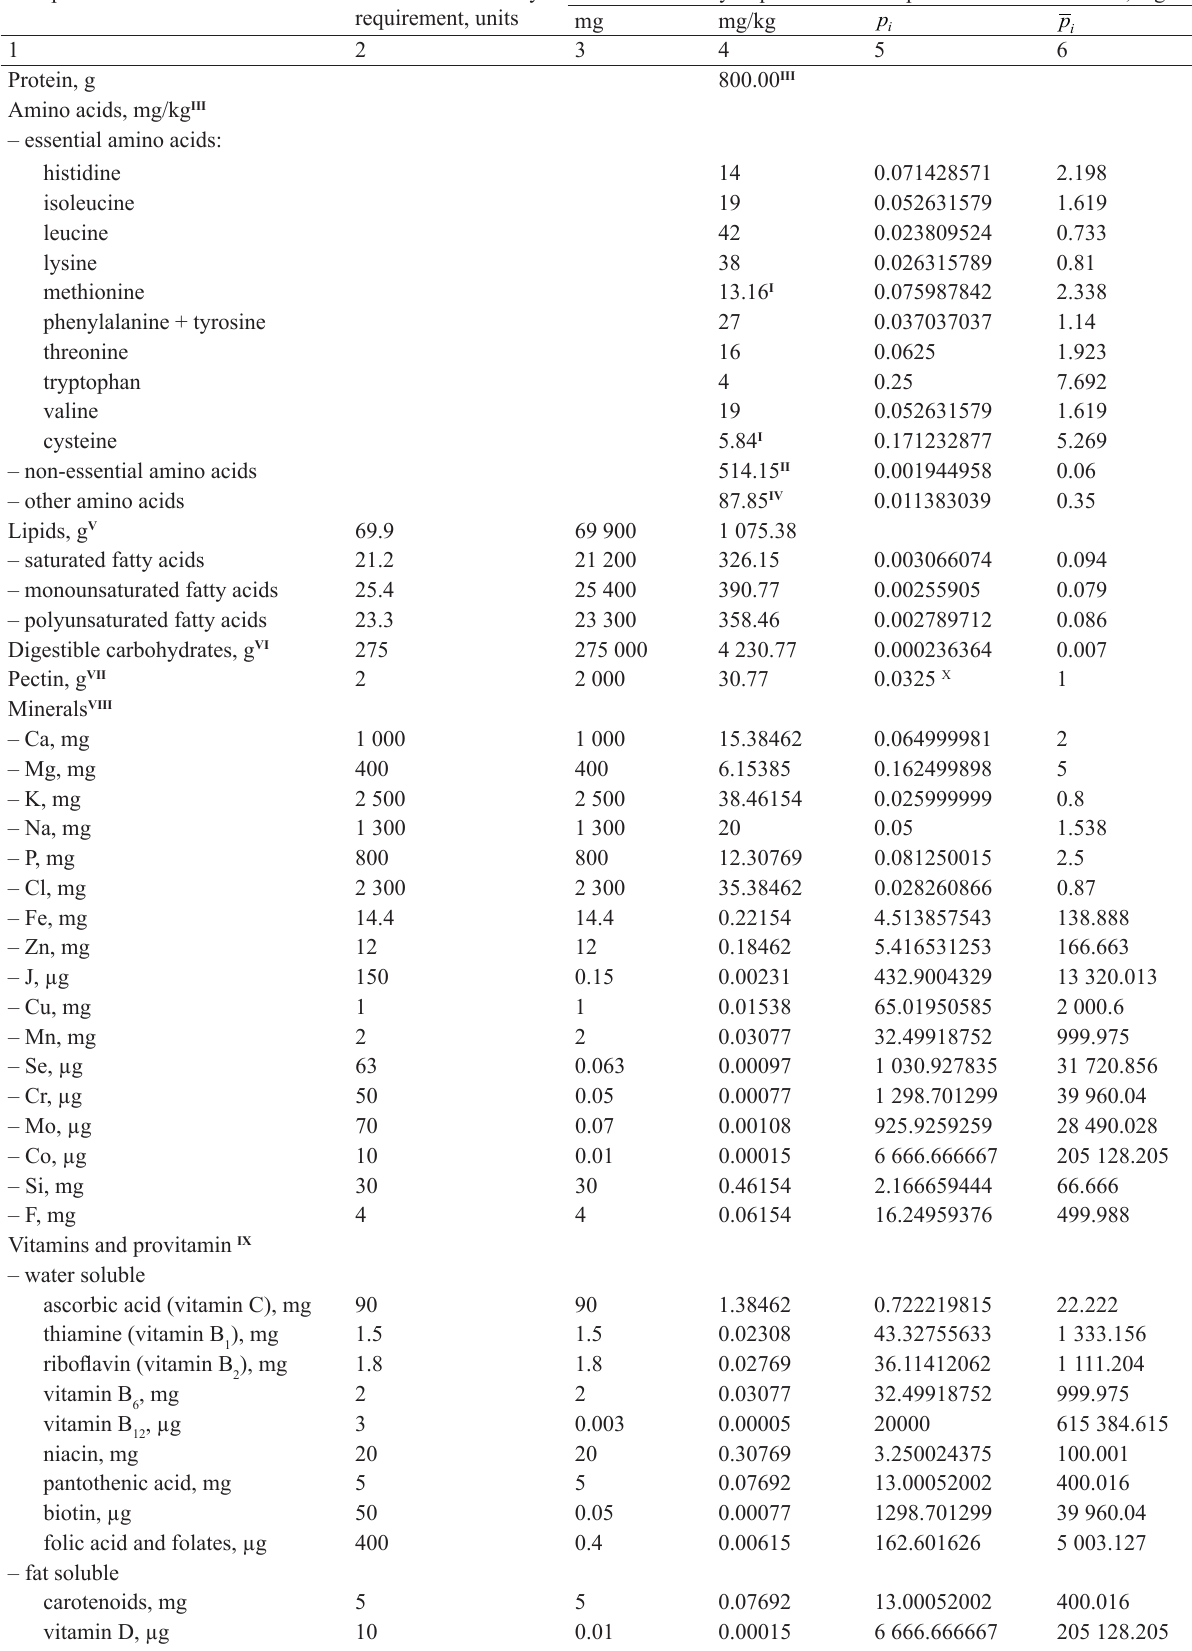
Table 1 Specific measures of value for biologically active components and pectin in 100 g of plant tissue